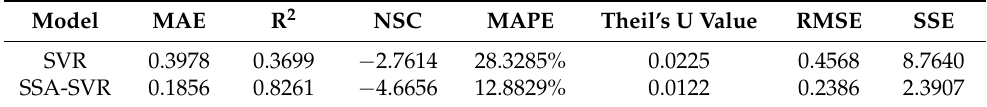
Table 5. Evaluation index values of SVR and SSA-SVR models.